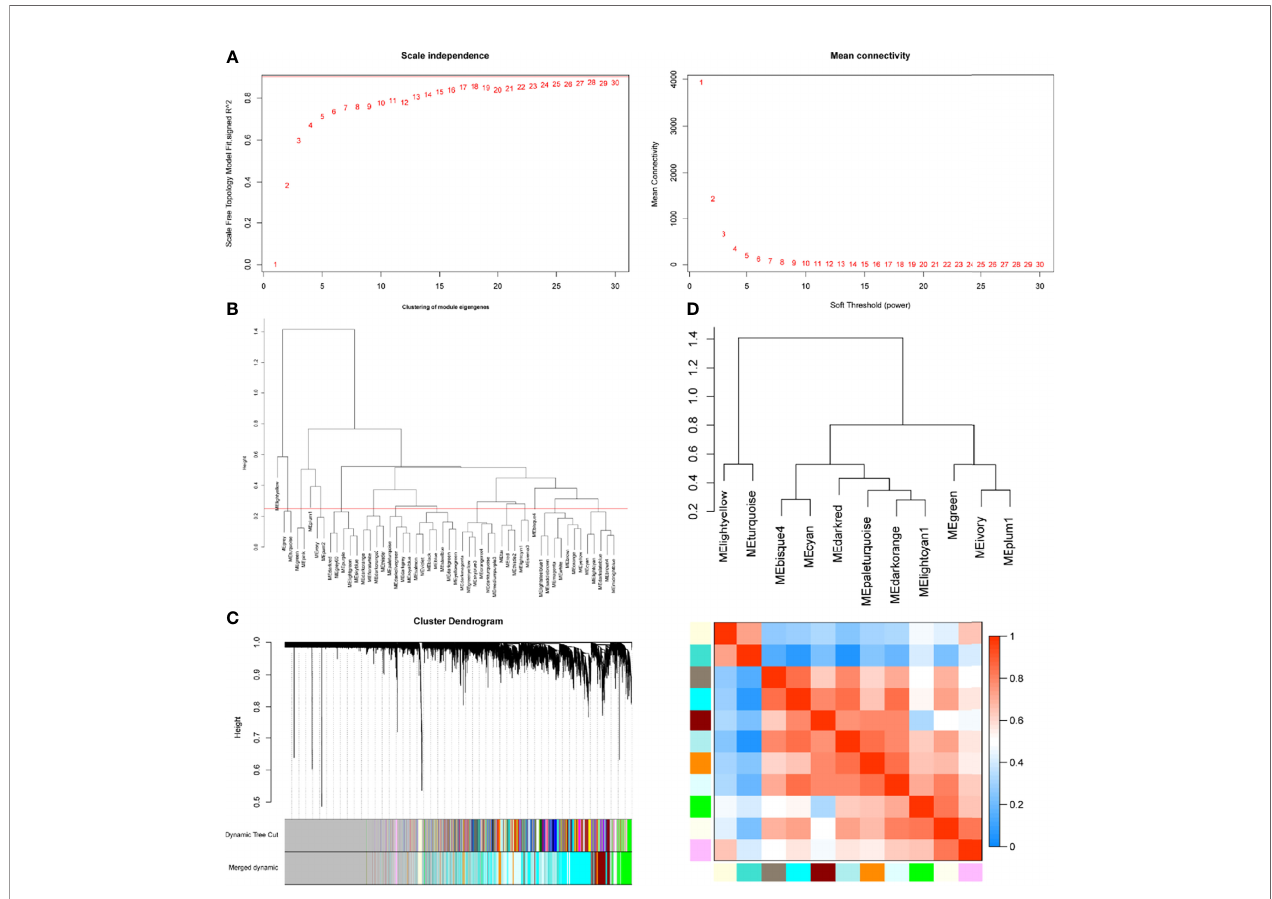
FIGURE 2 | Determination of soft-threshold power in the WGCNA. (A) Left: Analysis of the scale-free topology model fi t for various soft-threshold powers ( b ). Right: Analysis of the mean connectivity for various soft-threshold powers. (B) Clustering of module eigengenes. The red line represents MEDissThres=0.25. (C) Dendrogram of all differentially expressed genes clustered based on the measurement of dissimilarity (1-TOM). The branches correspond to modules of highly interconnected groups of genes. (D) The cluster dendrogram and adjacency heatmap of